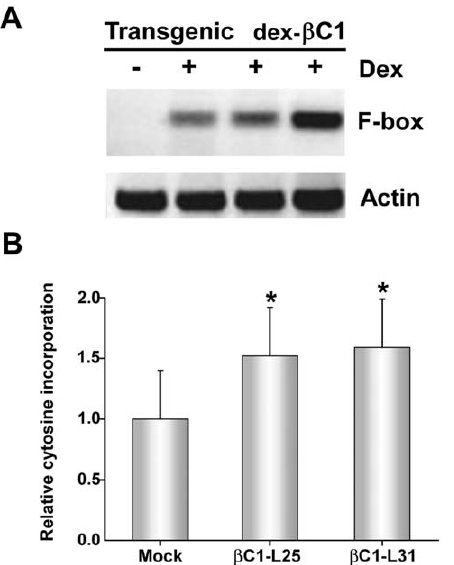
Figure 5. Transgenic expression of b C1 inhibits methylation and suppresses epigenetic TGS. (A) Arabidopsis plants from three independent lines containing a dex-inducible b C1 transgene (dex- b C1) were treated with dex ( + ) or mock-treated (-), and expression of a putative F-box locus known to be methylated and transcriptionally silenced was assessed by sqRT-PCR. Actin served as a control. Mock treated samples were prepared by pooling RNA from the three transgenic lines. Data shown are representative of at least three independent experiments. (B) The histogram illustrates relative incorpo- ration observed in the methylation-sensitive extension assay using MspI. Extracts from two transgenic lines ( b C1-L25 and b C1-L31) were tested following dex treatment. Two independent experiments were per- formed. In each experiment, assays were performed in duplicate with DNA from three individual plants per treatment. Mock treatment assays contained DNA isolated from plants of both transgenic lines. Values representmeans + /- SE. Asterisks indicate significant differences between mock and dex-treated samples at the 95% confidence interval, as determined by Student’s t